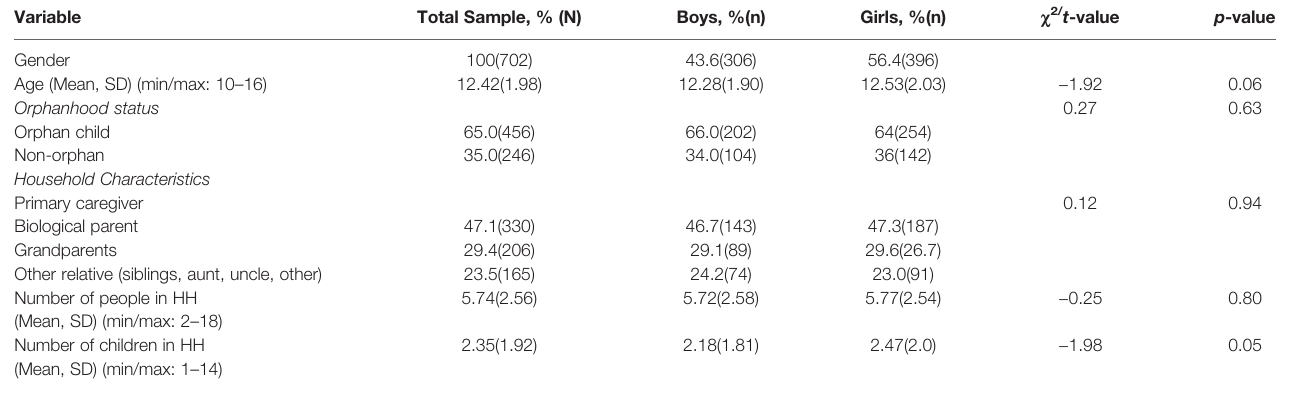
TABLE 1 | Baseline Characteristics of the Sample (N = 702).